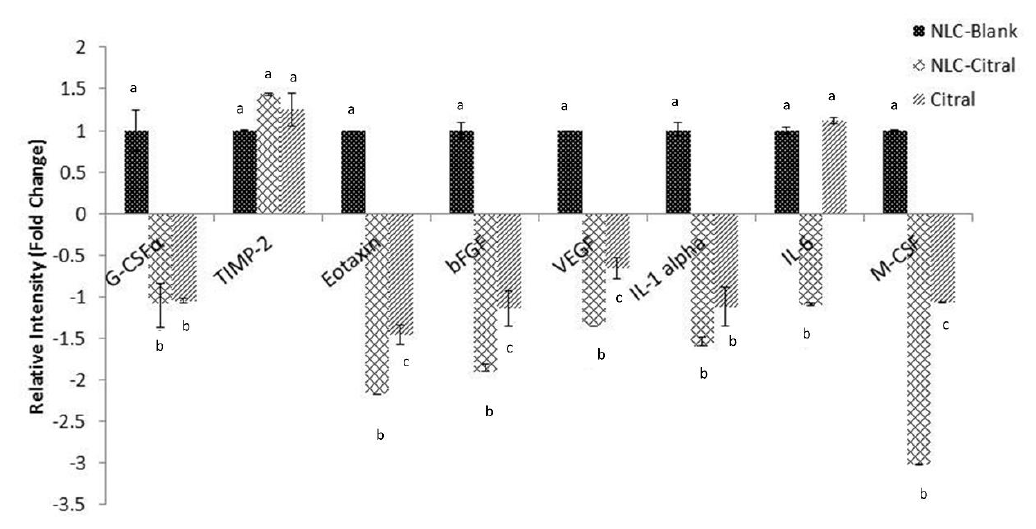
Figure 9. The relative mRNA expression level of MMP-9, iNOS, NFK- β, C -MYC, and ICAM. Each value is represented as mean ± SD and the experiment was performed in triplicate. Significance indicated by different alphabet was set at p < 0.05 comparing between groups.